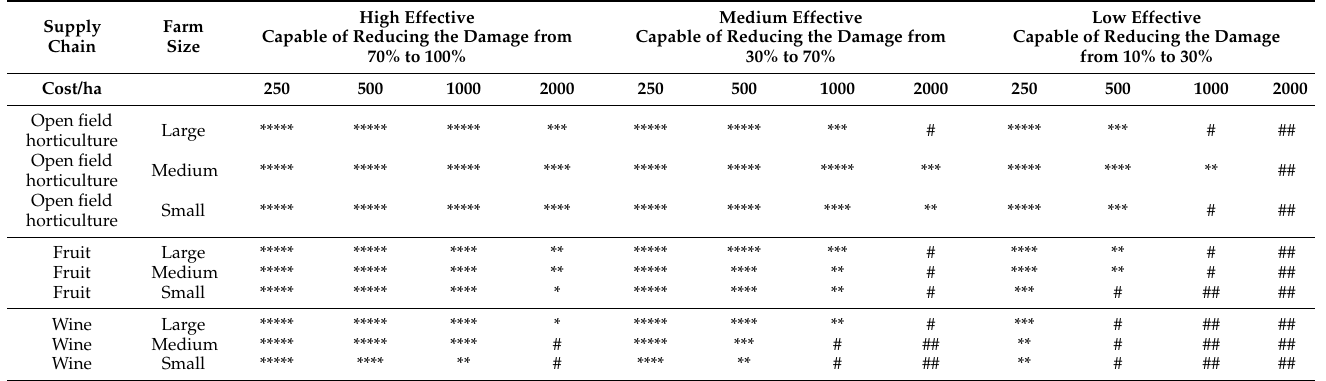
Table 2. Economic convenience degree of the adaptation measure